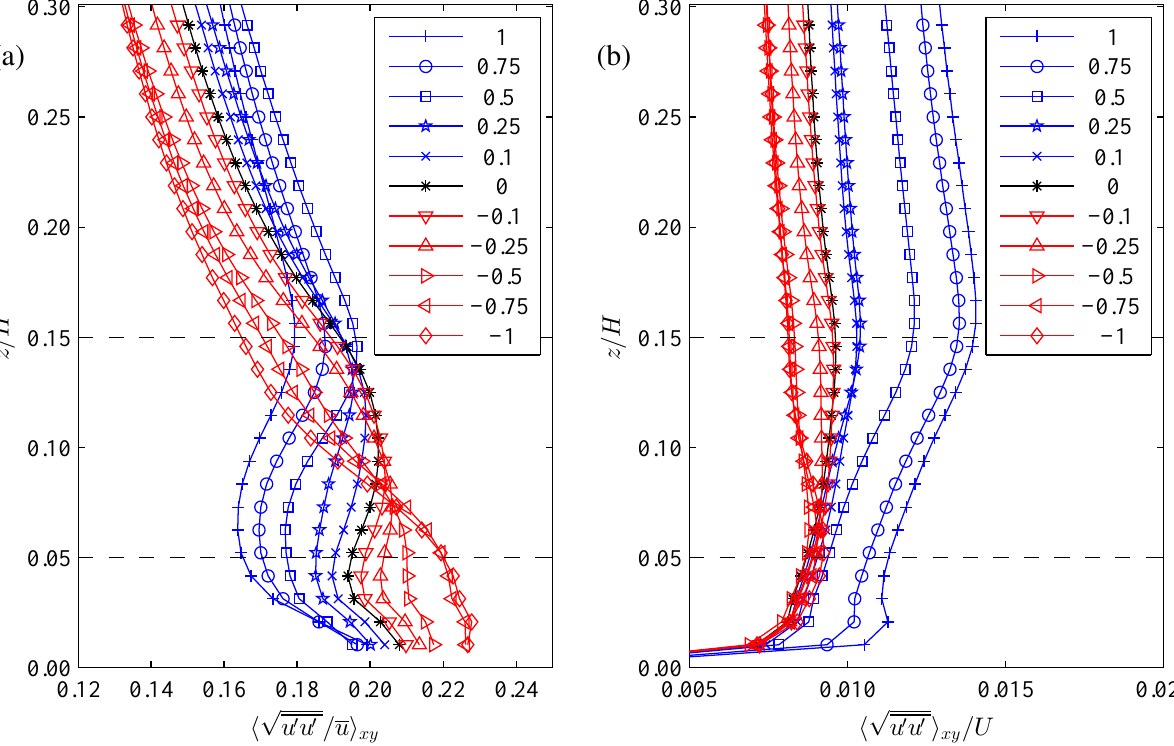
Figure 3. ( a ) The turbulence intensity (TI) and ( b ) the streamwise root mean square velocity, averaged across entire horizontal planes, are shown as a function of the height above ground for each forcing case, with the forcing parameter A given in the legend. The turbine rotors are located in the region between the dashed